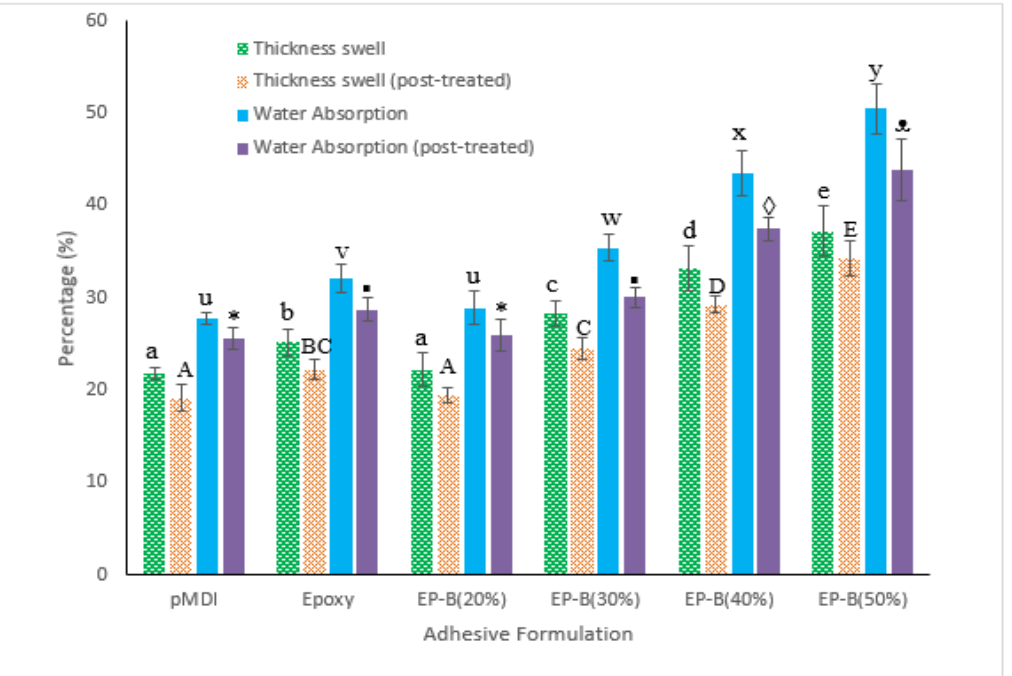
Figure 8. Thickness swell (TS) and water absorption (WA) bonded with the epoxy and epoxy-substituted bio-oil at 20%, 30%, 40%, and 50% bio-oil contents. EP-bio-oil (%): epoxy resin substituted with bio-oil. Different letters and symbols on the bar represent significant TS and WA ( p < 0.05). Post-treated means were analyzed separately. Error bars represent standard deviation.